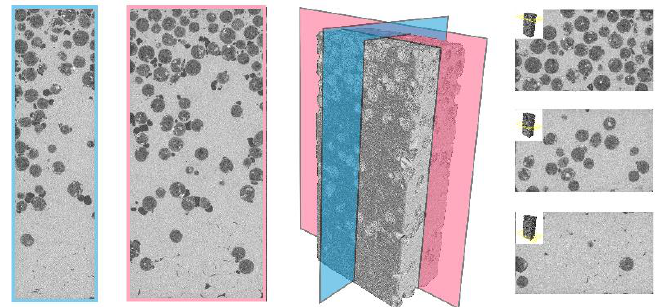
Figure 4. CT scan layers of half of the 0-100-0 LECA sample.